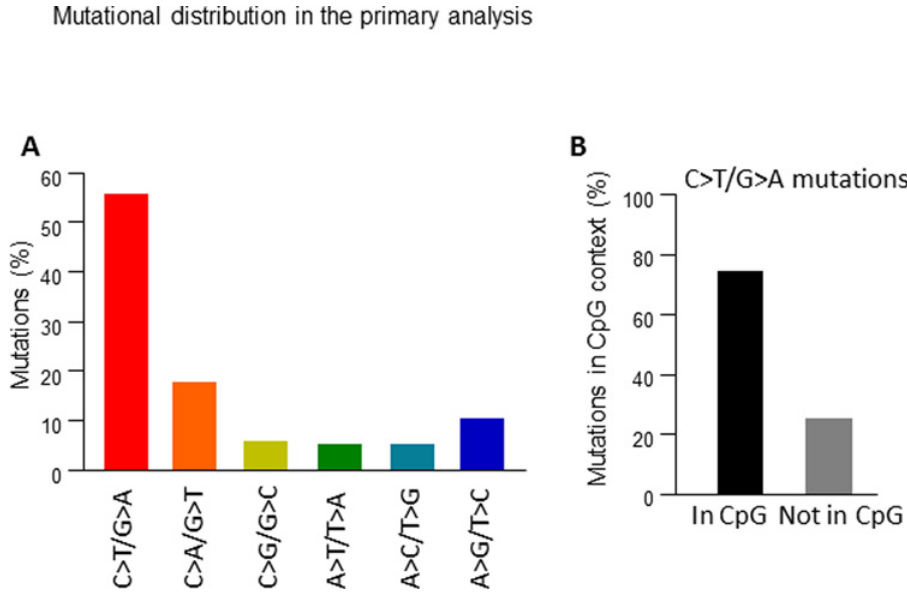
Fig 4. Distribution of mutations detected in the primary analysis. A). Percentage of the indicated mutations detected in the primary analysis. B) Percentage of mutations in CpG dimers.